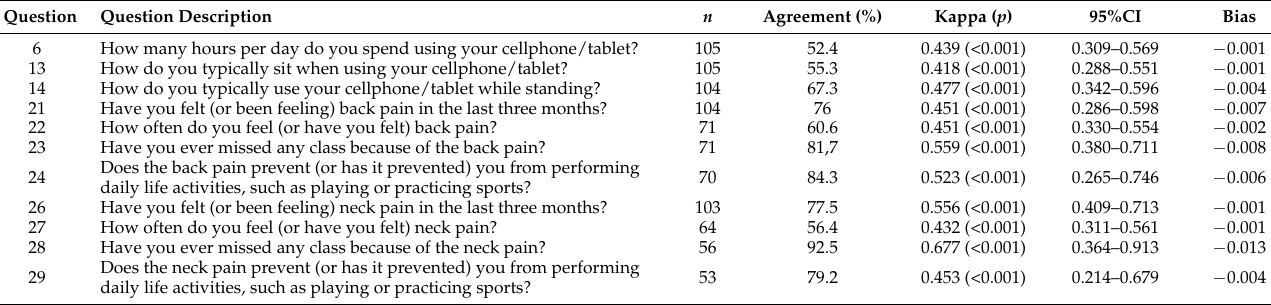
Table 4. Results of test-retest reliability of BackPEI-CA new